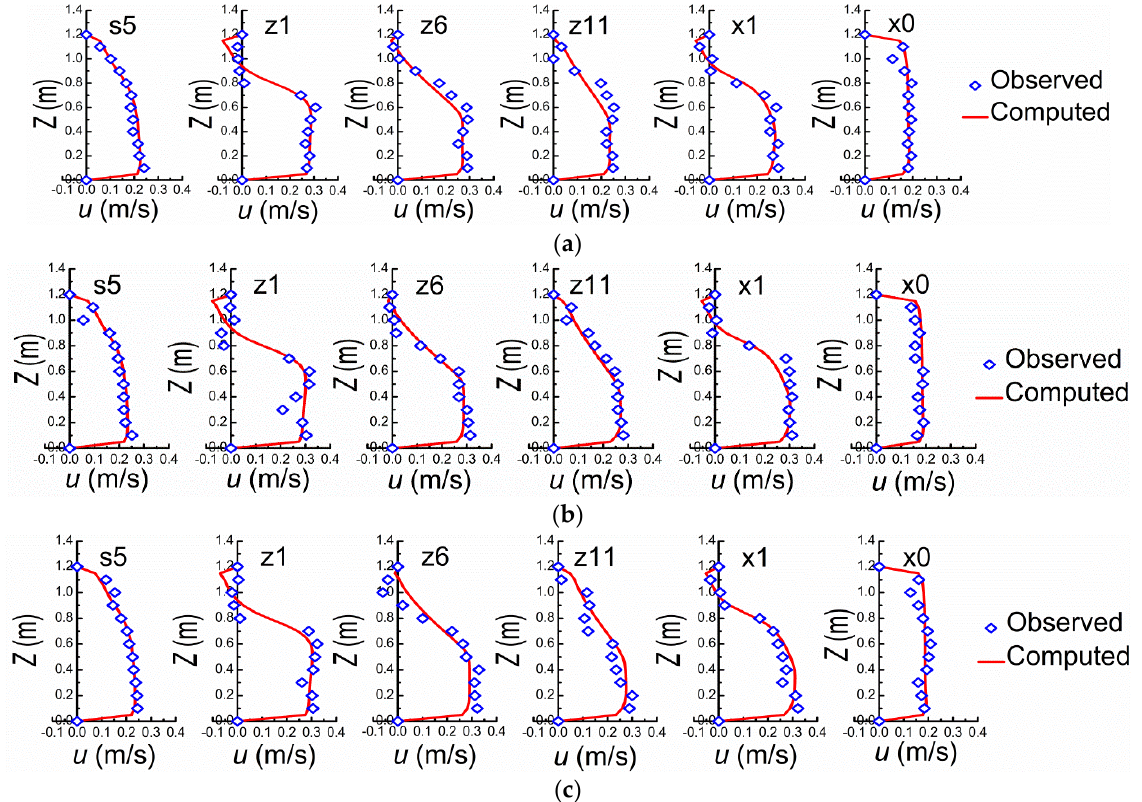
Figure 4. Comparisons of u along Z between observed and computed. ( a ) Y = 0.08 m. ( b ) Y = 0.16 m. ( c ) Y = 0.24 m.